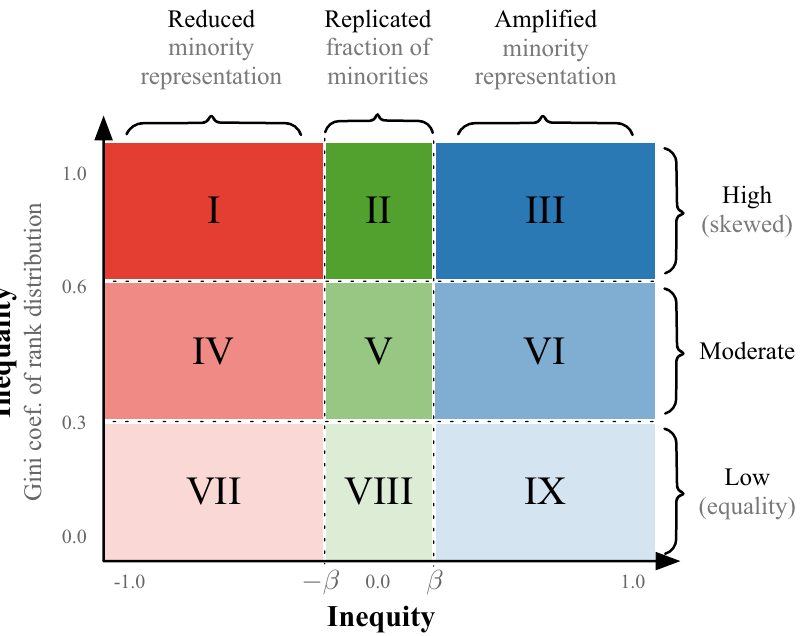
Figure 2. Regions of disparity. We measure inequality (y-axis) as the skewness of the rank distribution, and inequity (x-axis) as the mean differences between the proportional representation of groups in top-k% ranks and the network. Highly skewed distributions lie in regions I to III (darker colors), and fair rankings, where minorities are well represented in top ranks, lie in regions II, V, VIII (green). We set β = 0.05 which is arbitrary and allows for a flexible region of group fairness